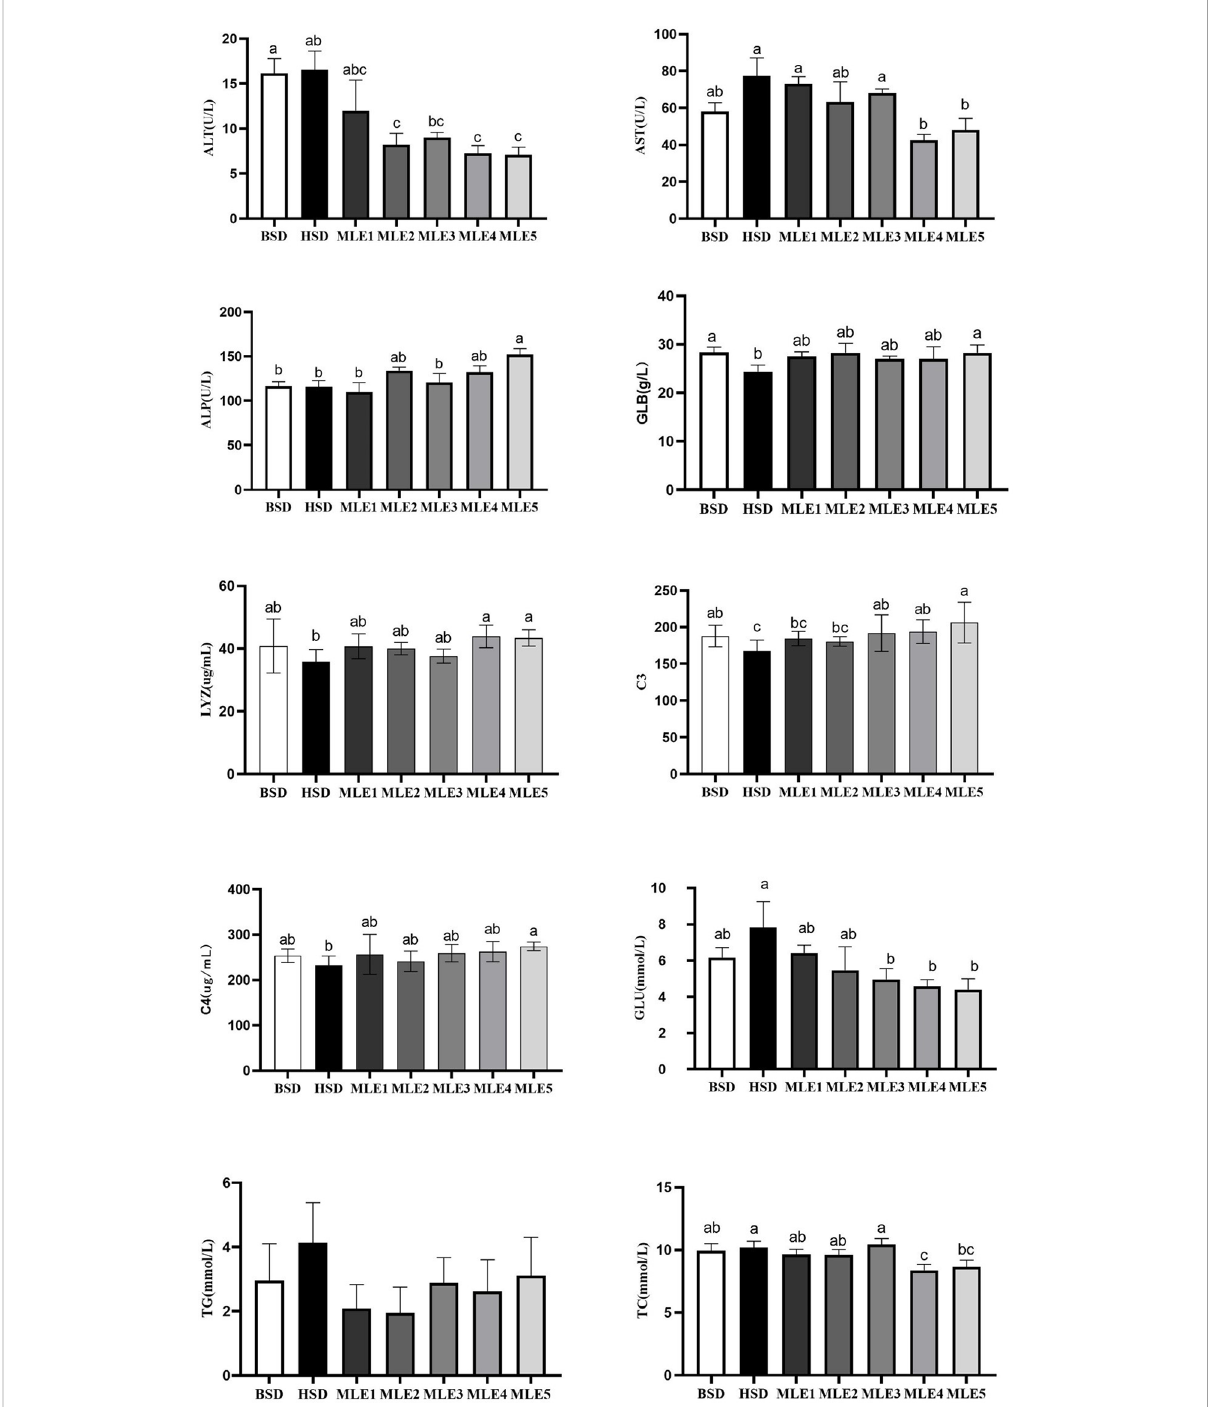
FIGURE 2 Effects of mulberry leaf extract on non-speci fi c immune indices and plasma biochemical parameters of Micropterus salmoides fed high-starch diet diets. Values in each column with different superscripts have signi fi cant differences (p<